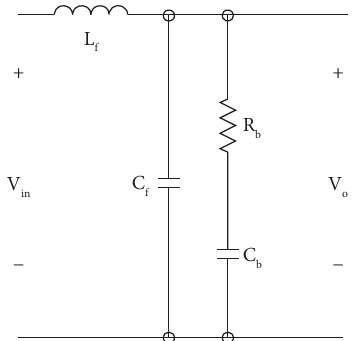
Figure 5: LC flter with series